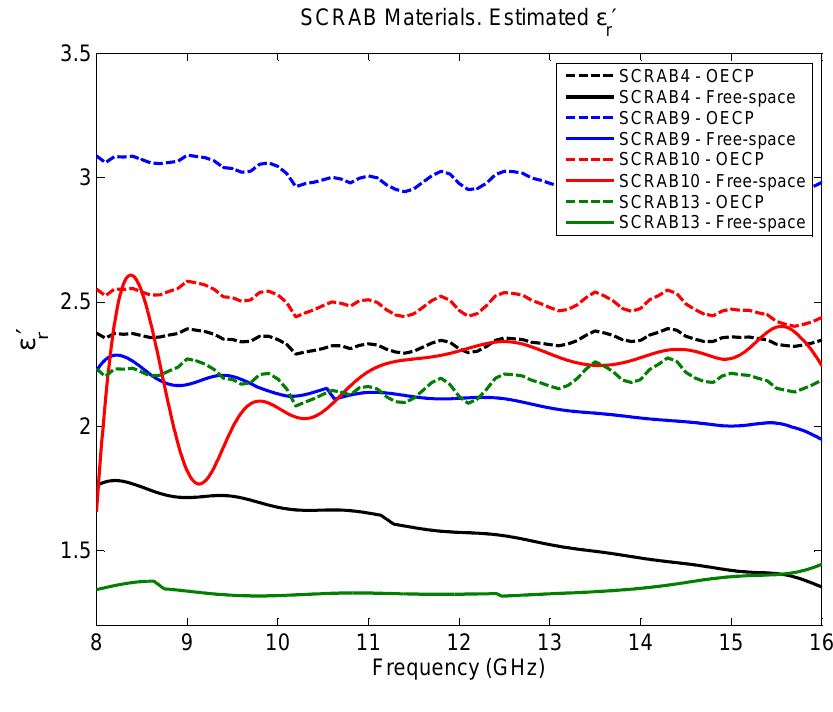
Figure 6. SCRAB-II materials estimated permittivity: (cid:101) (cid:48) r . Table 2. SCRAB-II materials under test. Extracted mean permittivity (f = 8–16 GHz) for open-ended coaxial-probe (OECP) and